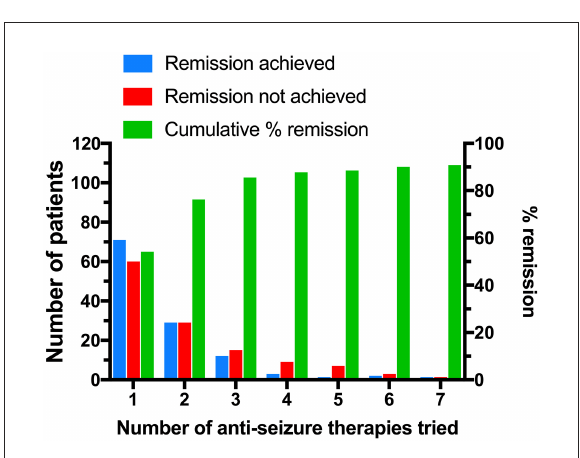
FIGURE2 Success of ASM therapy on achieving remission. Blue: patients who have achieved remission on particular ASM therapy (monotherapy or combination therapy). Only patients who did not switch to next ASM treatment for any reason (such as side effects) were considered to have achieved remission for the purpose of this figure. Red: patients who have not achieved remission on particular ASM therapy. Green: cumulative percentage of patients achieving remission (right y